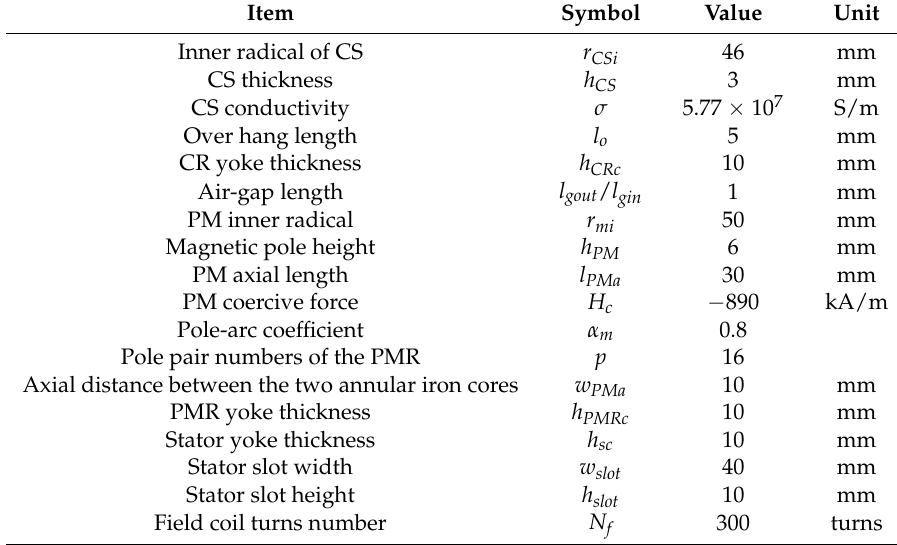
Table 1. Major design parameters of the